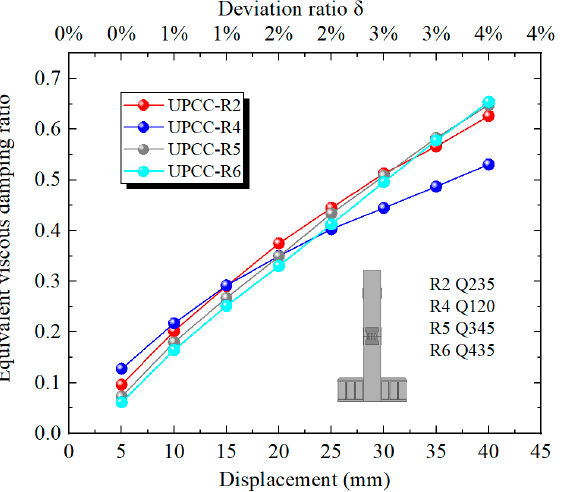
Figure 26. Equivalent viscous damping ratio under different steel yield strength of EREDL. According to the residual displacement loading displacement curves of three groups of different initial prestressed pier specimens in Figure 27, when the initial reciprocating loading displacement reaches 5 mm, the residual displacement of four groups of specimens is basically the same, indicating that under small displacement loading, the influence of EREDL strength on the residual displacement of specimens can be ignored. When the displacement is loaded to 10 mm, the residual displacement of R2, R5 and R6 groups of specimens with higher EREDL strength is basically the same, while the residual displace- ment of R4 is significantly smaller than that of the other three groups of specimens. When the load reaches 15 mm, the residual displacement of R5 and R6 is approximately the same, while that of R2 is smaller than that of R5 and R6. When the load reaches 25 mm, the residual displacement of the R5 and R6 groups of specimens starts to differ, and the residual displacement of specimens with smaller EREDL strength is smaller. From the above analysis, it can be seen that in the initial stage of loading, the strength of EREDL has no obvious effect on the residual displacement of the test piece. However, with the gradual increase in displacement load, the residual displacement of the test pieces with different EREDL strengths starts to differ. The smaller the strength of EREDL, the smaller the load displacement whose residual displacement growth amplitude starts to